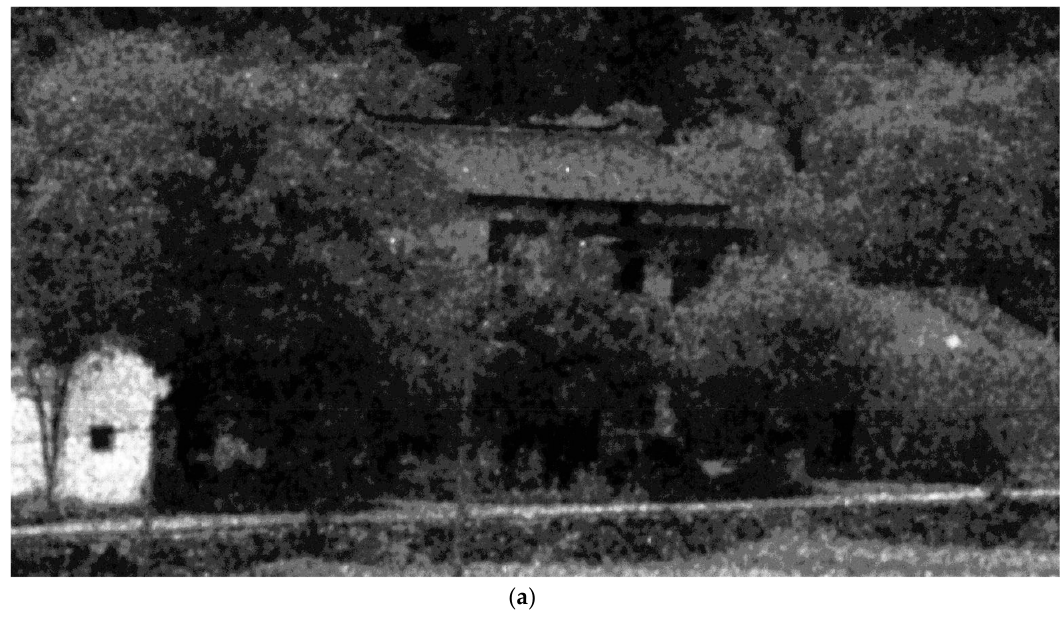
Figure 8. The subjective results of the proposed scheme and others. ( a ) a real ICCD sensing image; ( b ) the result of the proposed scheme; ( c ) the result of BM3D; ( d ) the result of the denoising method based on the K-SVD; ( e ) the result of BLS-GSM.